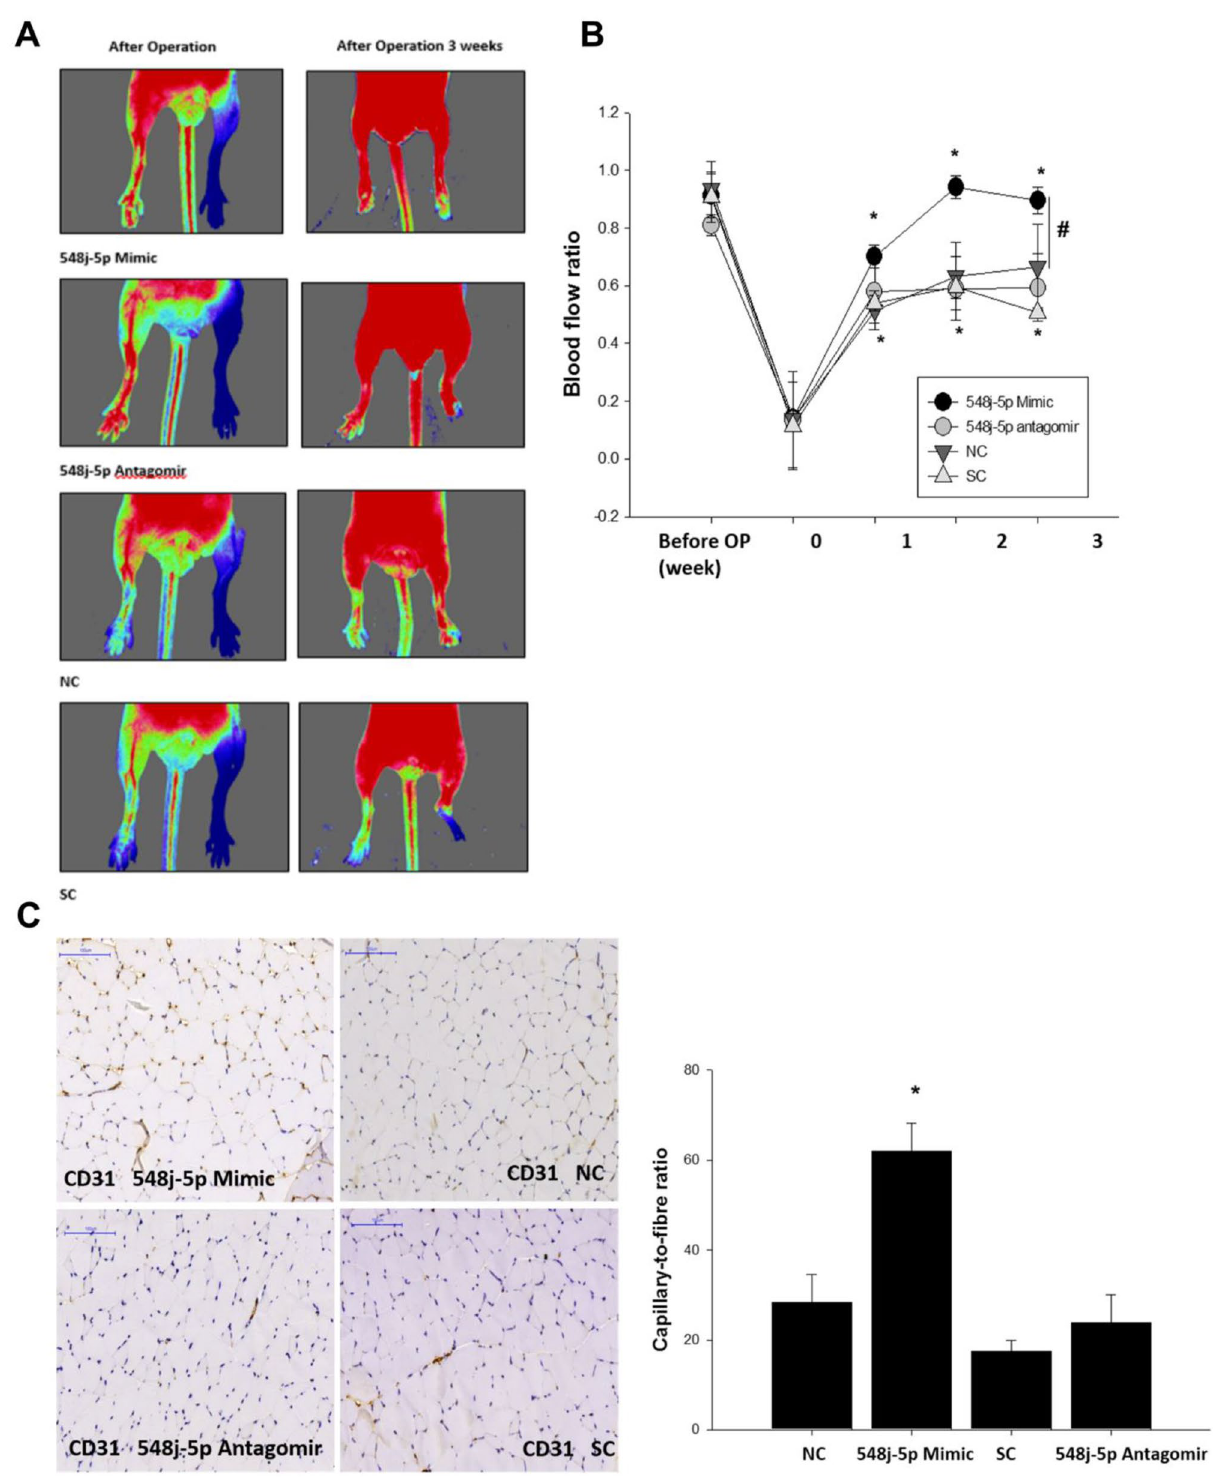
Figure 6. Effect of miR-548j-5p on hindlimb perfusion. ( A ) Serial Doppler analysis of hindlimb perfusion before and 3 weeks after hindlimb ischemia surgery in nude mice that received transplants of EPCs transfected with miR-548j-5p mimic, miR-548j-5p antagomir, miR-mimic negative control (NC) or miR-scramble control (SC). The color scale illustrates blood flow variation from minimal (dark blue) to maximal (red) values. Arrows indicate the ischemic limb after hindlimb ischemia surgery. ( B ) Quantification of perfusion recovery using the laser Doppler perfusion imaging ratio (ischemia/normal hindlimb) in the different groups. ( C ) Mice were sacrificed 3 weeks after surgery, and capillaries in the ischemic muscles were visualized using anti-CD31 immunostaining. Data are presented as the mean ± SEM (* P < 0.05 vs. NC; # P < 0.05 vs. miR-548j-5p antagomir, n = 6 for each